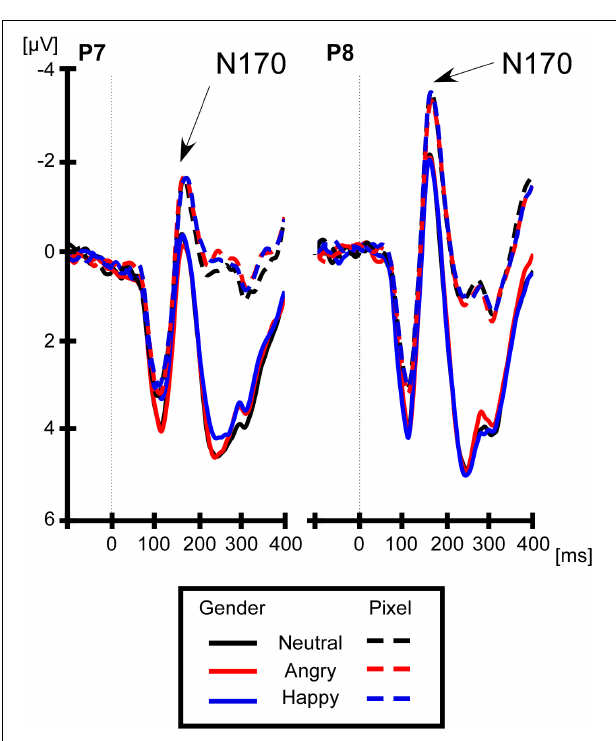
FIGURE 2 | Non-lateralized N170 to facial expressions at P7/P8. The N170 is more negative on the right (electrode P8) than on the left hemisphere (electrode P7). However, the type of facial expression did not affect the non-lateralized N170, neither in the gender (solid line) nor in the pixel task (dashed